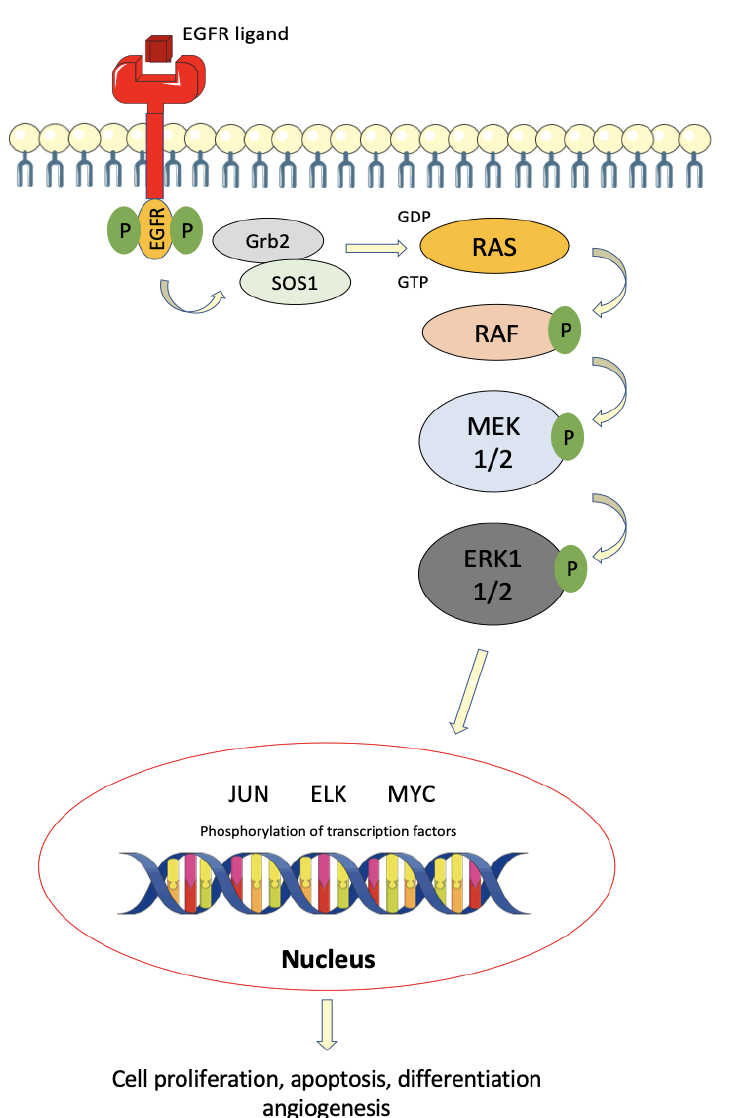
Figure 1. Schematic diagram of the ERK/MAKP signaling pathway in colorectal cancer. Initiation with an extracellular stimulus, EGFR ligand, which binds to and activates the EGFR receptor on the cell membrane. Downstream activation of RAS, RAF, and MEK, in that order, converges in the activation of the ERK1/2 transcription factor activator. This pathway ultimately induces cell proliferation, apoptosis, differentiation, angiogenesis, and metastases.